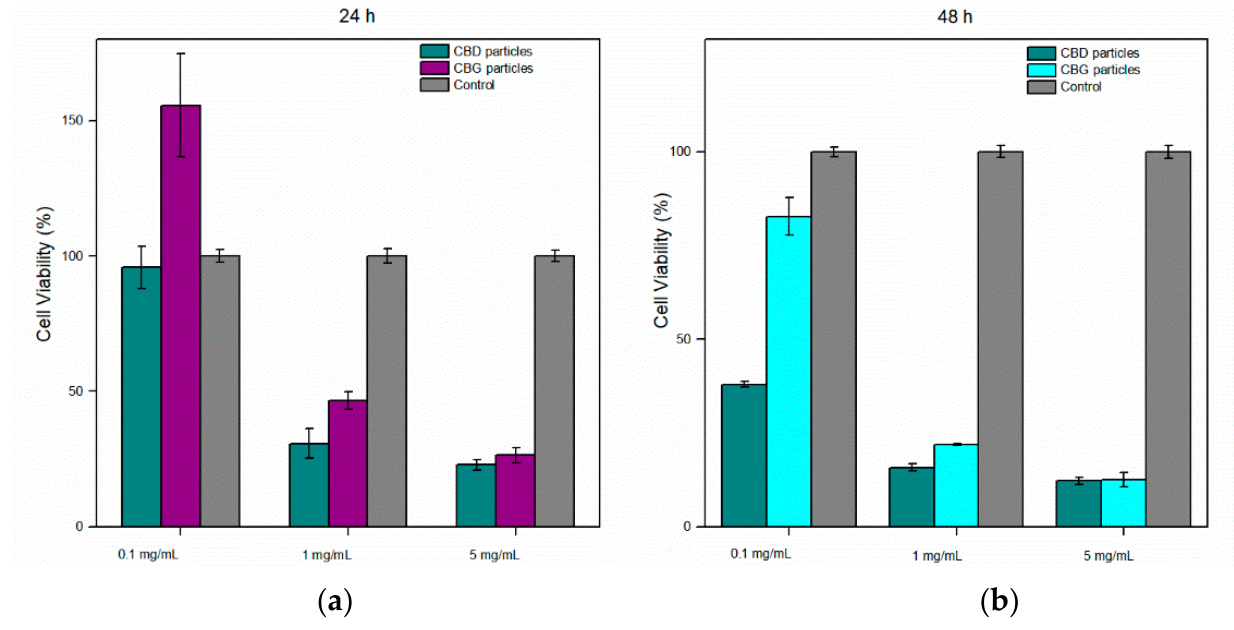
Figure 10. Cell viability of HaCaT cells after exposure to various concentrations of CBD and CBG particles ( a ) after 24 h and ( b ) after 48 h, as measured by the MTT assay.